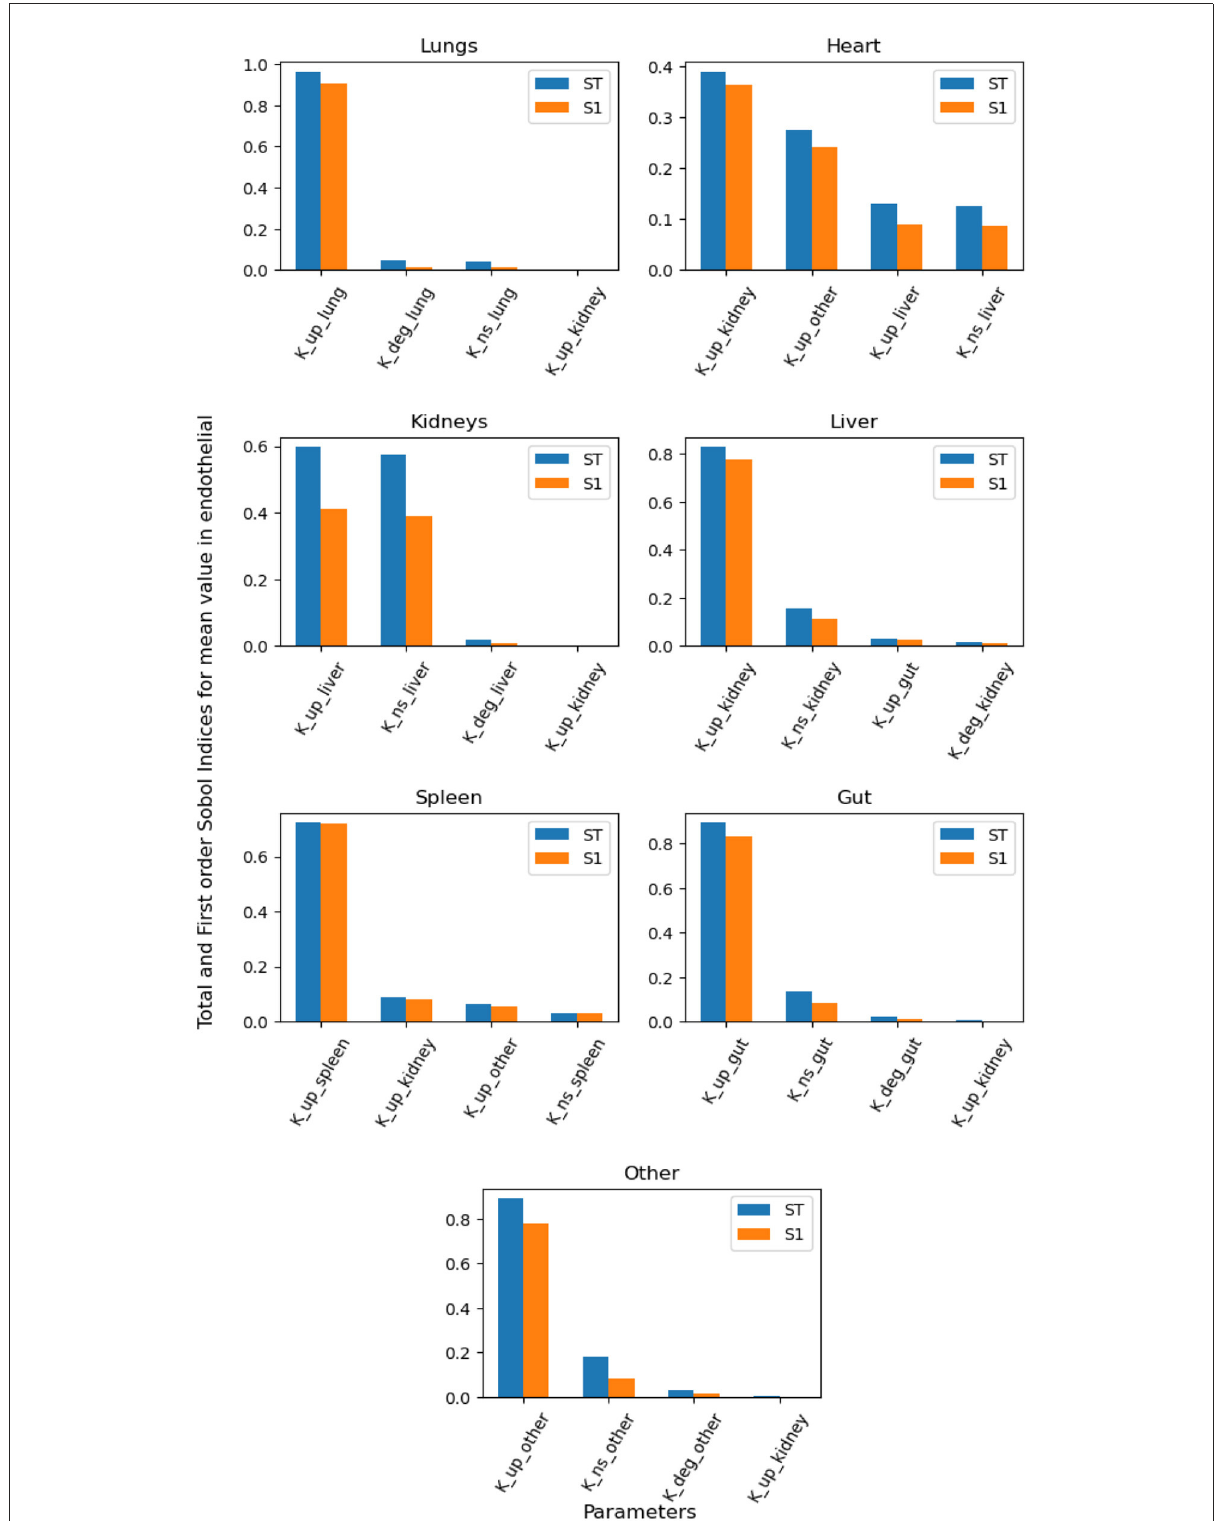
FIGURE6 Global Sensitivity Analysis: Total order and First-order Sobol indices of K deg , K up , and K NS parameters, for global sensitivity analysis performed on mean value of NPs bound to endohtelial